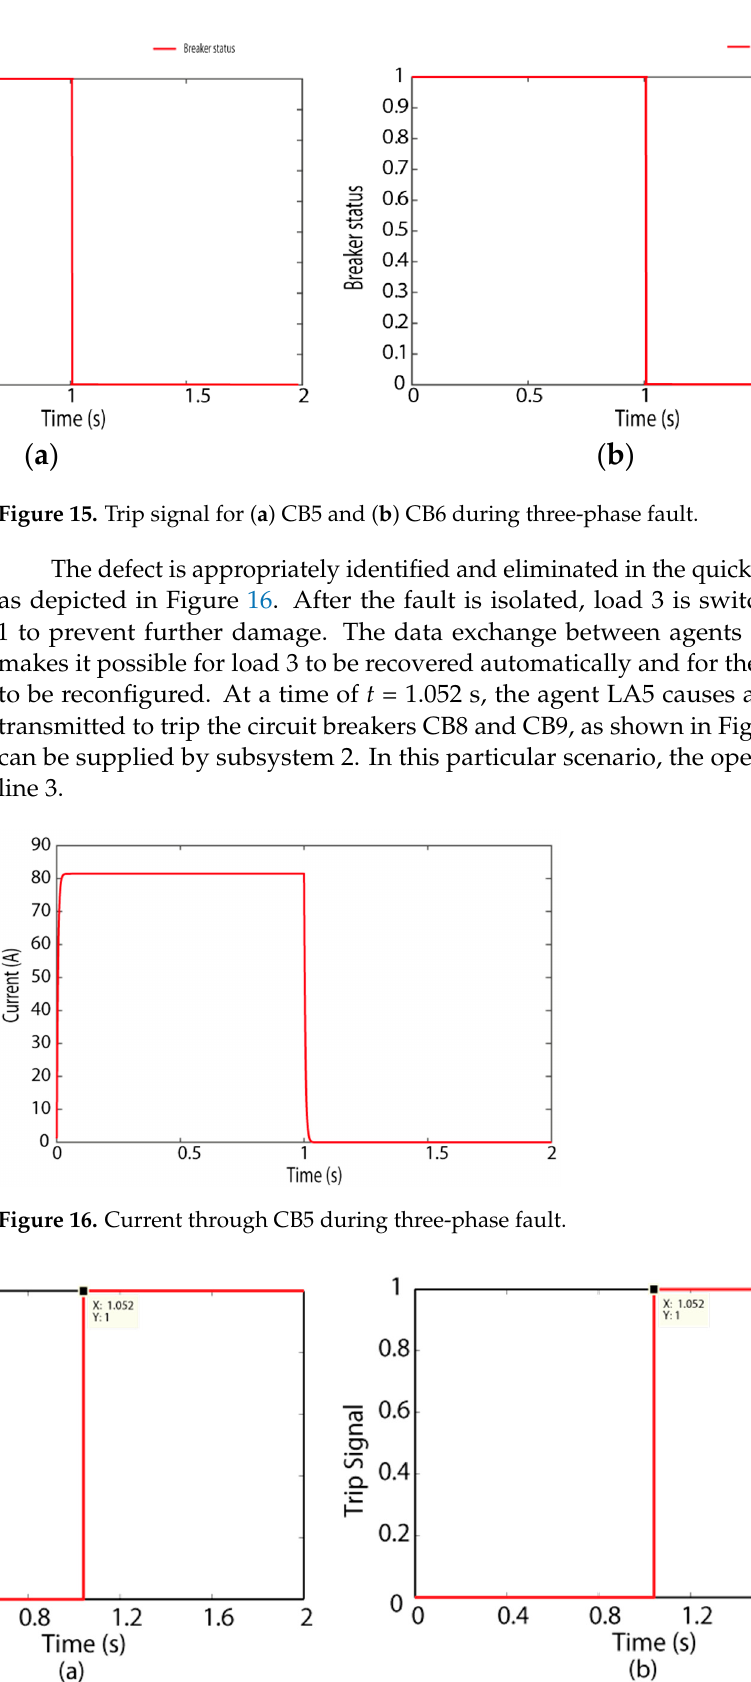
Figure 14. Three-phase current during the fault in line 3.